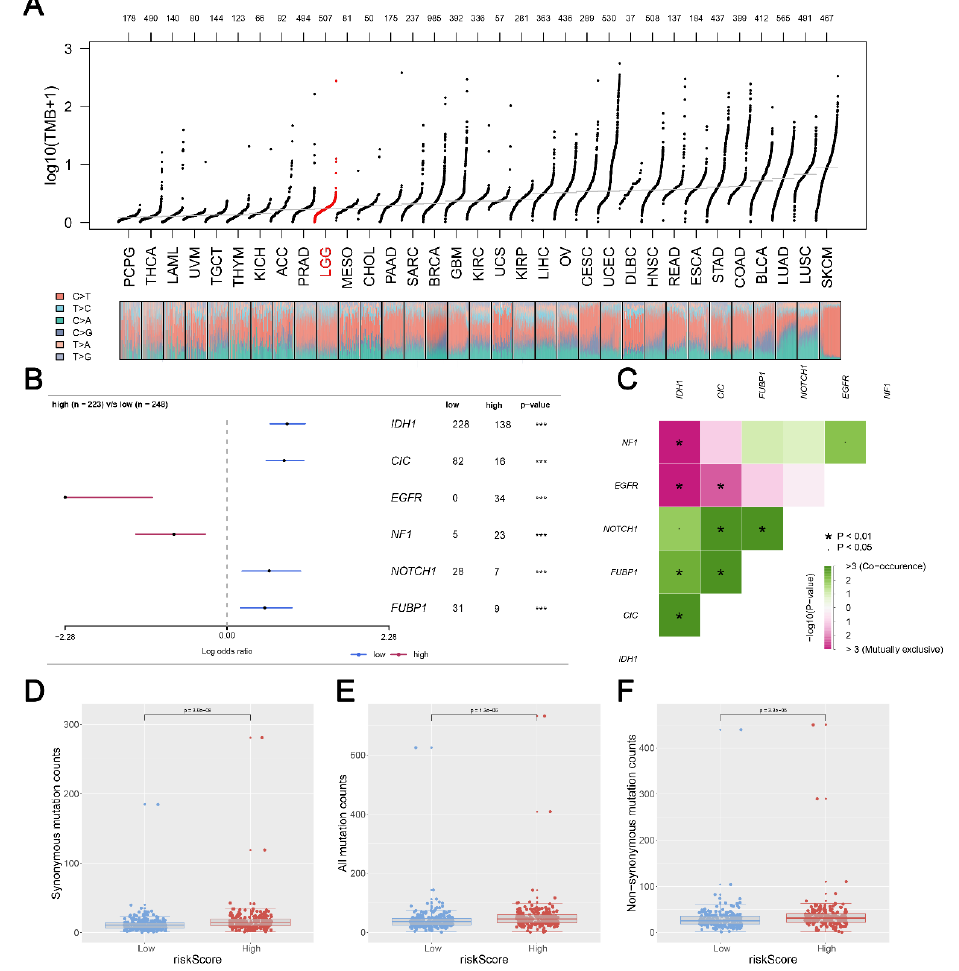
Figure 7. Correlation of risk score with tumor mutational burden ( TMB ) . Notes: ( A ) TMB distribution of Pan-cancer in TCGA; ( B ) a total of 6 genes mutated more frequently were identified, including IHD1; ( C ) the heatmap showed the correlation between these 6 genes identified by maftools analysis; ( D – F ) patients with high risk score showed a higher level of somatic mutations counts including non-synonymous counts, synonymous mutations counts and all mutations counts.(* p < 0.05, ** p < 0.01, *** p < 0.001).